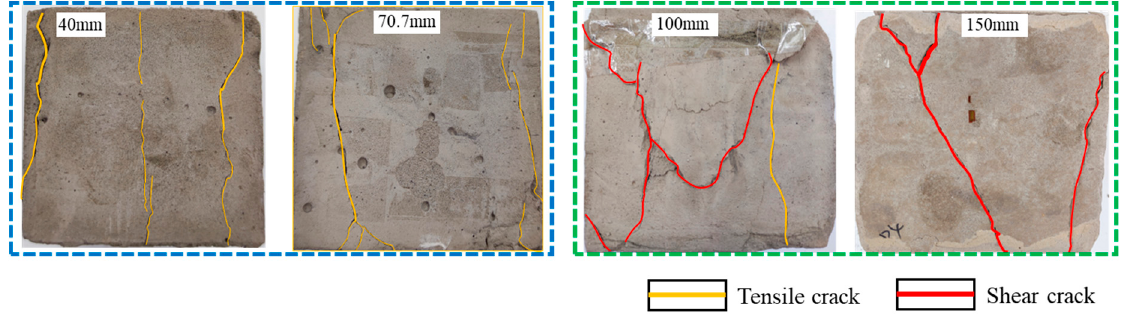
Figure 7. Failure patterns of